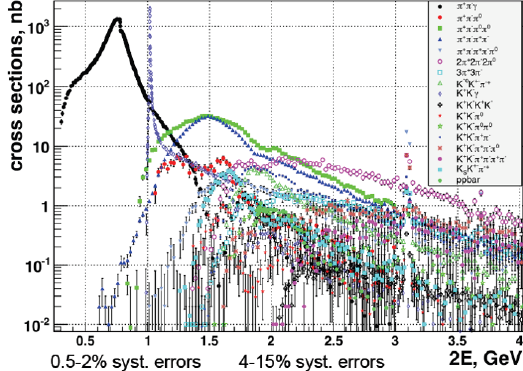
Figure 9: Study of the processes from ISR at BaBaR.